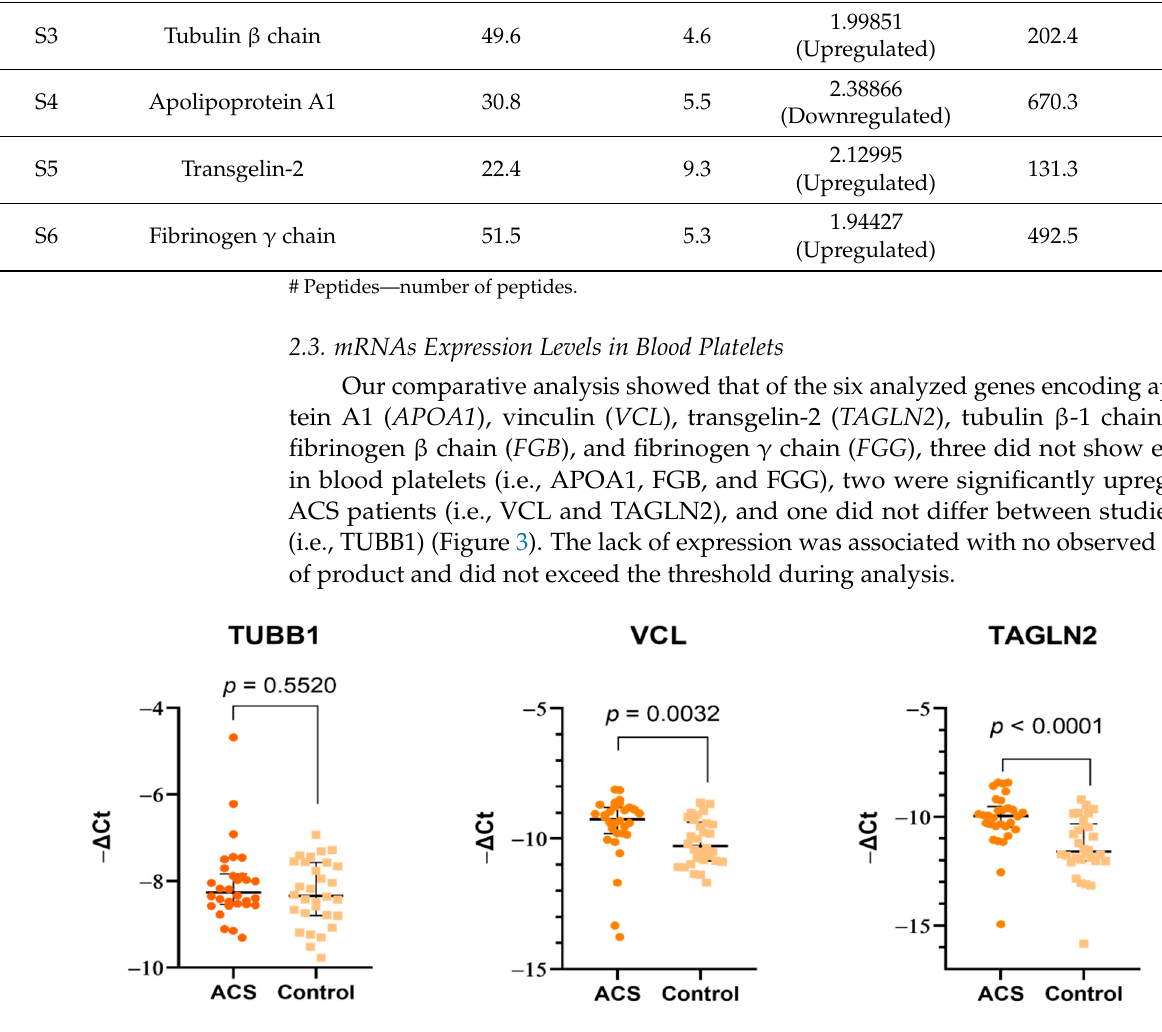
Figure 3. The mRNA expression levels of TUBB1, VCL, and TAGLN2 in blood platelets of ACS patients and healthy donors. The relative expression was assessed by the − ∆ Ct value. As a reference gene, 18S rRNA was used. Data are plotted as individual values with horizontal bars representing medians and interquartile range. p -Values were calculated using the Mann–Whitney U test.